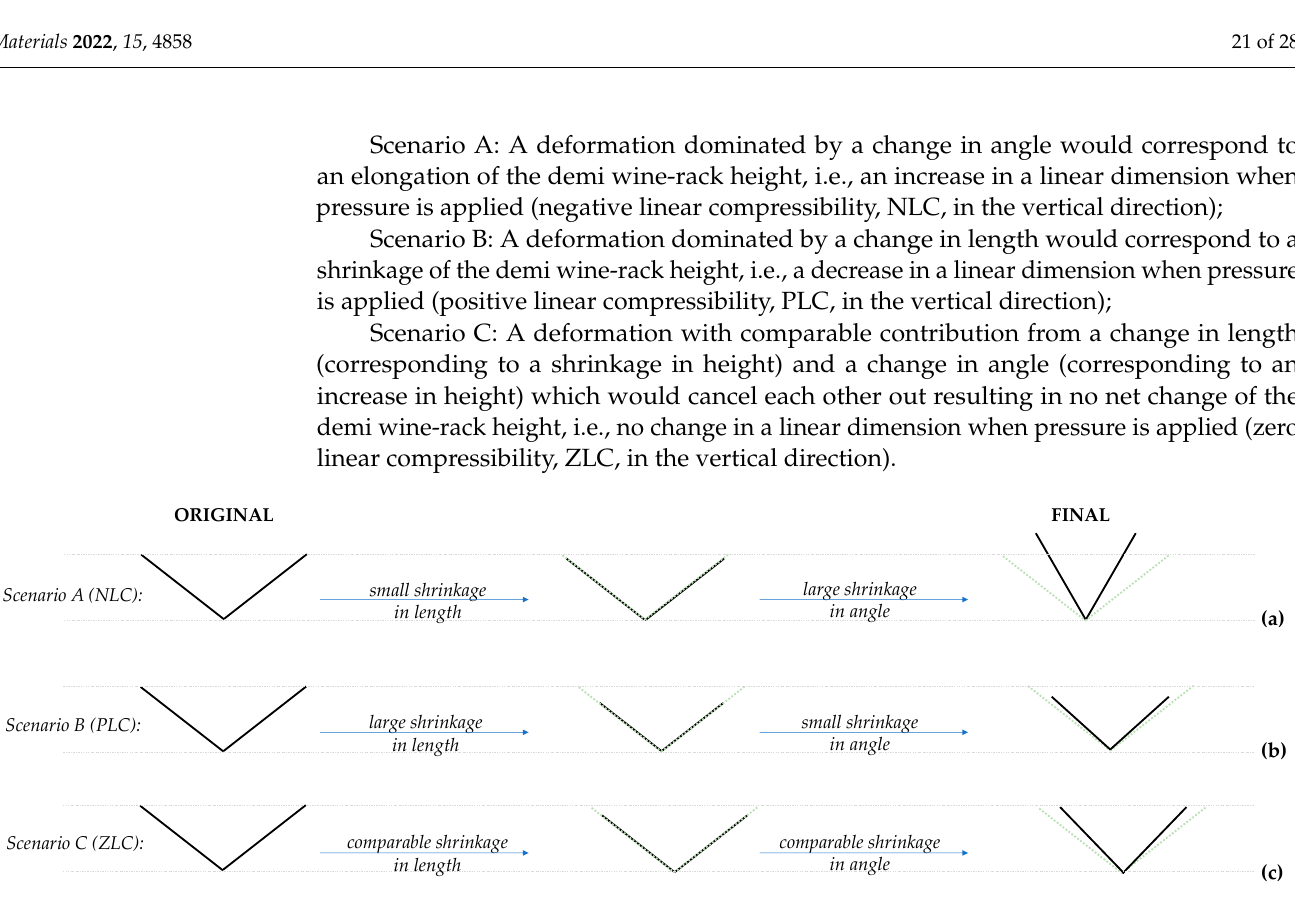
Figure 14. An illustration of how ( a ) negative linear compressibility (NLC), ( b ) positive linear compressibility (PLC) and ( c ) zero linear compressibility (ZLC) manifest in the vertical direction. Recognising that in this case, the V-shaped demi wine-rack units correspond to either two O-As bonds at angle O-As-O to each other, or, two O-B bonds at angle O-B-O to each other (half tetrahedra), from Figure 13, it is evident that Scenario A would clearly correspond to pressures of 15–45 GPa where change of angle dominates (Region II); Scenario C corresponds to around 5 GPa and somewhere in the region between 45–55 GPa, where the ‘positive’ and ‘negative’ contributions cancel each other out (transition between Region I and II and between Region II and III), and Scenario B corresponds to the extreme pressure regions of Region I and III. All this provides a formal verification of the cause for NLC